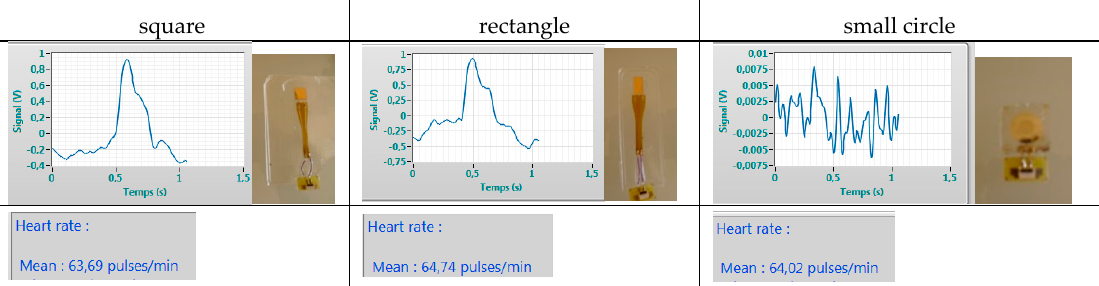
Figure 3. Relation between sensor shape and sensitivity (higher noise with small surface)—the reference pressure was taken with a standard tensiometer as 98 Systolic, 68 Diastolic and 66 beat per minute on the left arm while our sensor was used on the right